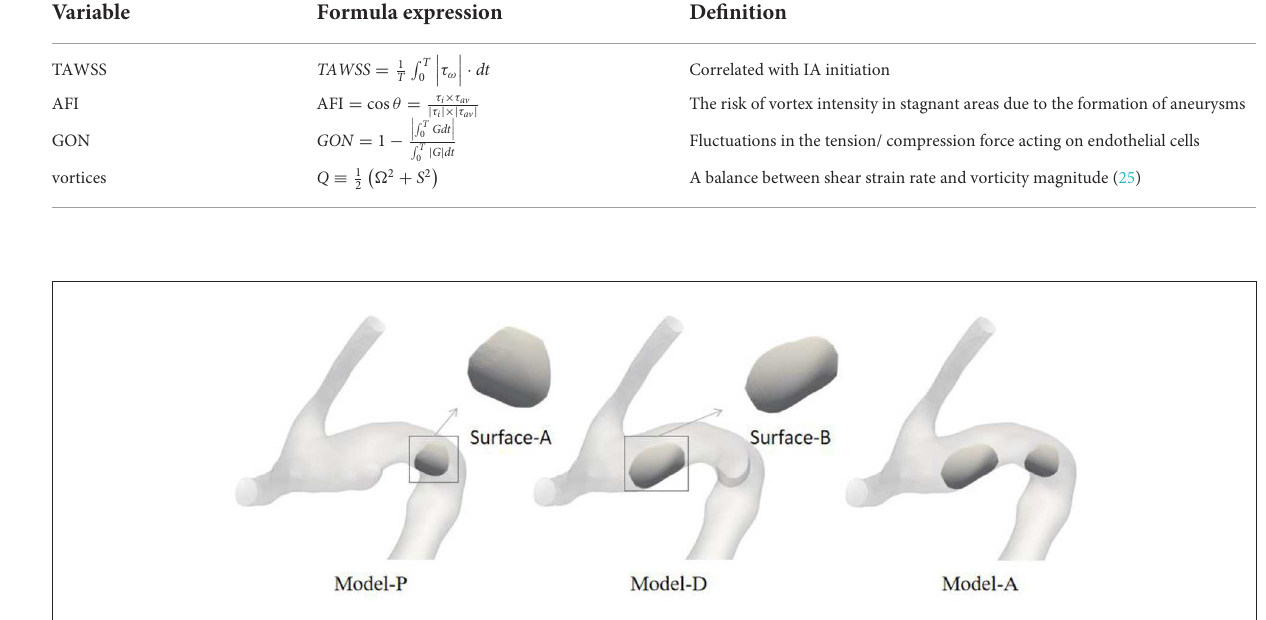
FIGURE2 Schematic diagram of the ROI of three different series of pre-aneurysm vasculatures.